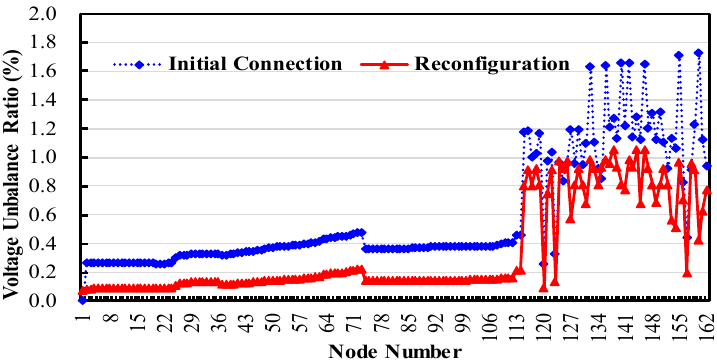
Figure 6. Comparison of the improvement in the voltage imbalance ratio for each node of the Taiwan Power Company (TPC) 162 ‐ node system.